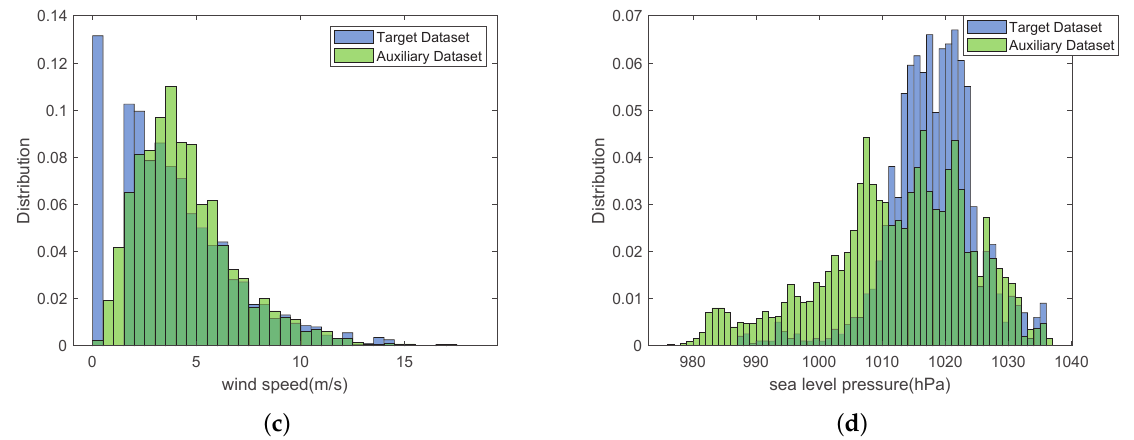
Figure 6. Different meteorological data distributions of two buildings: ( a ) air temperature, ( b ) dew temperature, ( c ) wind speed and ( d ) sea level